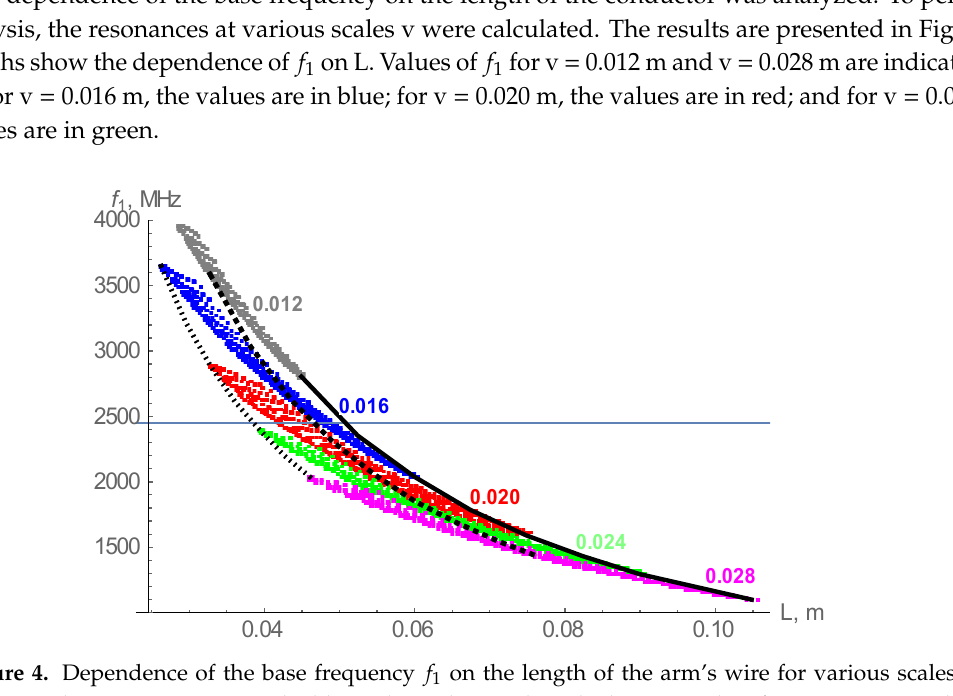
Figure 3. Balanced dipole wire antenna with an arm formed by the Koch-type prefractal of the second iteration.